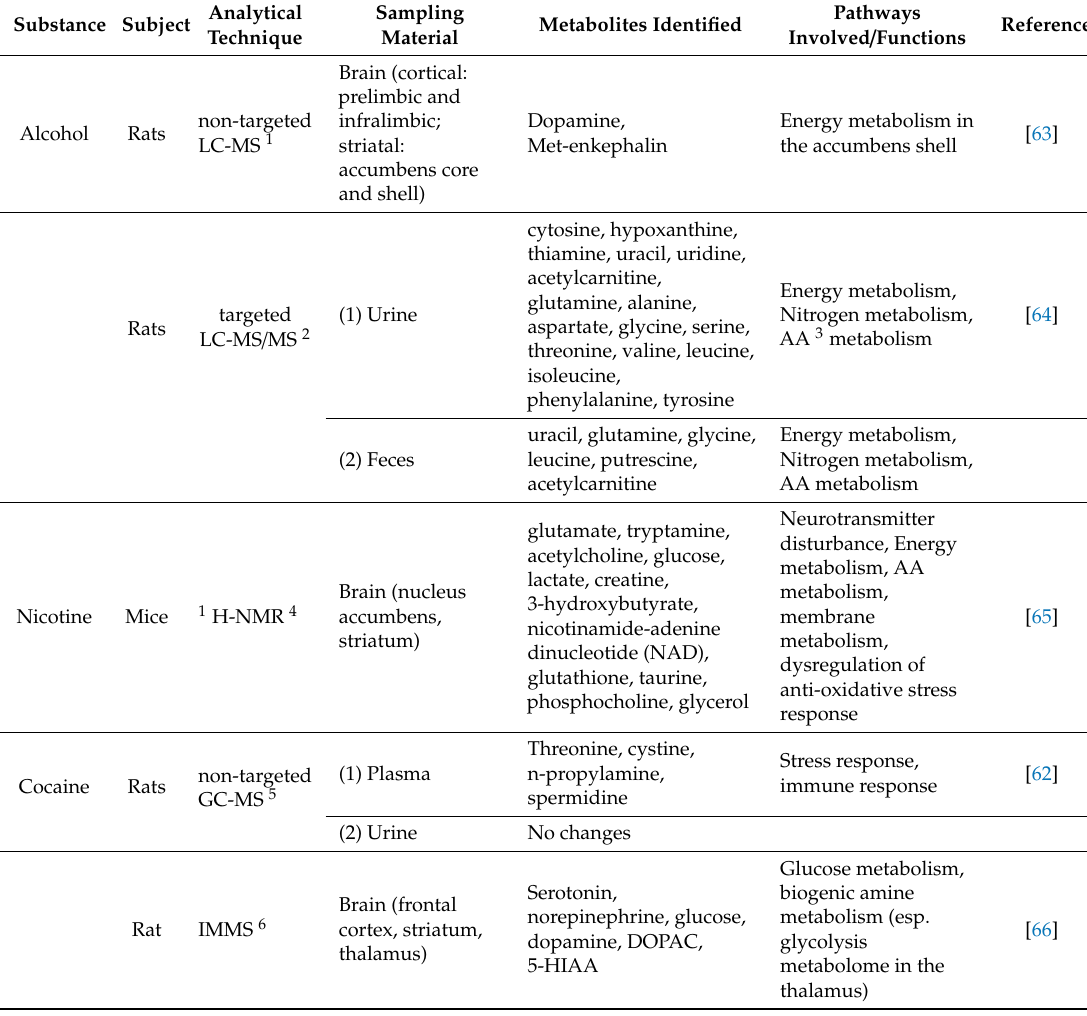
Table 4. Possible biomarkers identified in animal-based studies of various addictive